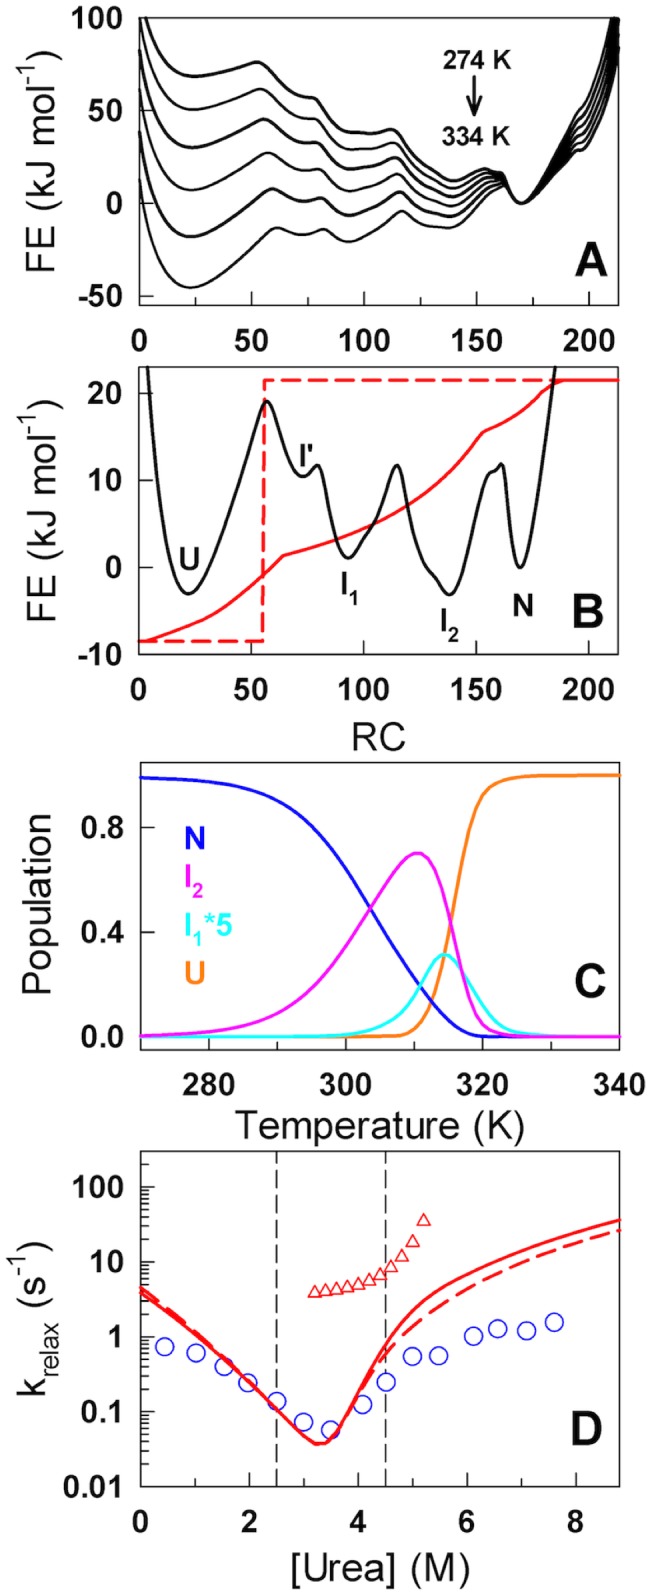
Intermediates and chevron roll-overs.(A) The predicted 1D free-energy profiles as a function of the number of structured residues (RC – reaction coordinate). (B) A closer look at the free energy profile close to the denaturation midpoint indicating the presence of two major intermediates (I1 and I2), a minor intermediate (I′) apart from the end states (U and N). The continuous red curve is the tryptophan signal calculated from the 2D structural ensemble while the dashed red curve is the assumed tryptophan signal switch. (C) Population of the major macrostates as a function of temperature. (D) Relaxation rates predicted by the model (continuous and dashed lines) compared with experiments (circles). The predicted rates were matched with the experimental midpoint relaxation rates assuming a single uniform diffusion coefficient of (7e6/N) n2 s−1 where n is the reaction coordinate value and N is the protein length. Triangles correspond to the faster phase observed in simulations.